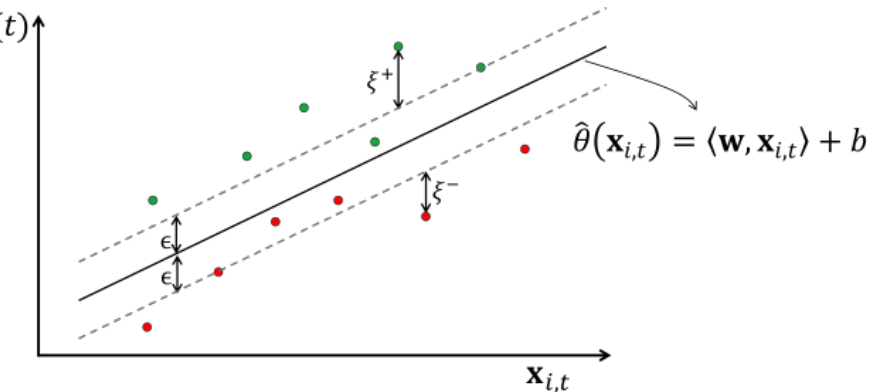
Figure 3. Development of the hyperplane for predicting temperature, with the green dots indicating over-prediction and the red dots indicating under-prediction.